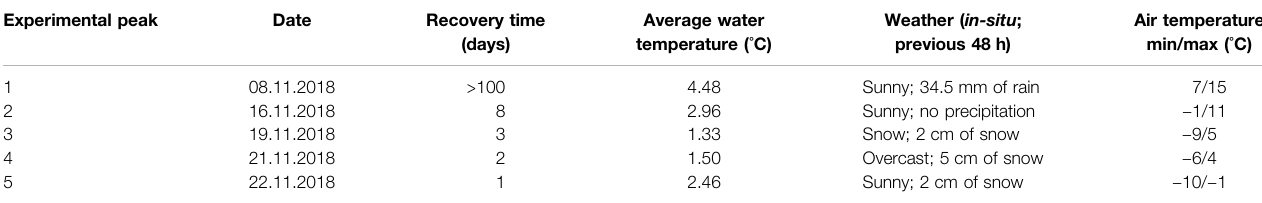
TABLE 1 | Summary table of basic site information including date of each experiment, average water temperature [HOBO Loggers ( ° C)], notes on weather, daily air temperature ( ° C) minima and maxima, and the duration of recovery time before each additional experiment (days). Experimental